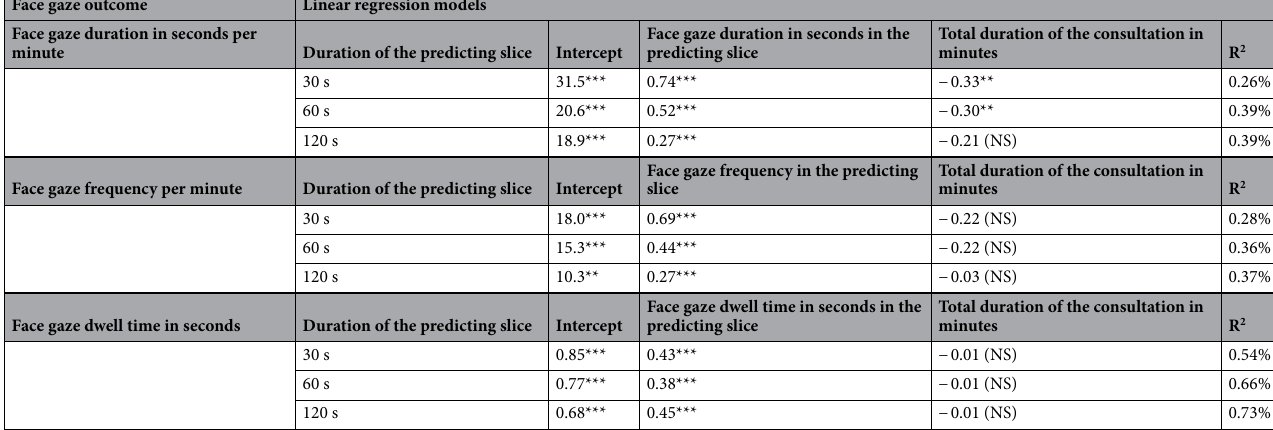
Table 2. Results of the linear regression models to predict face gaze duration per minute, frequency per minute, and dwell time with a varying slice time of 30, 60 or 120 s. NS: not significant, * p < 0.05, ** p < 0.01, *** p < 0.001. For each outcome, we used the level of face gaze in the initial slice, as well as total consultation duration in minutes and a model intercept. The model parameters are displayed for each linear model as well as the model